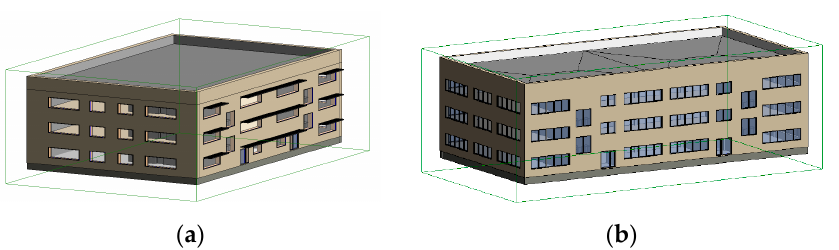
Figure 3. Building concept alternatives ( a ) based on technology; and ( b ) traditional design.